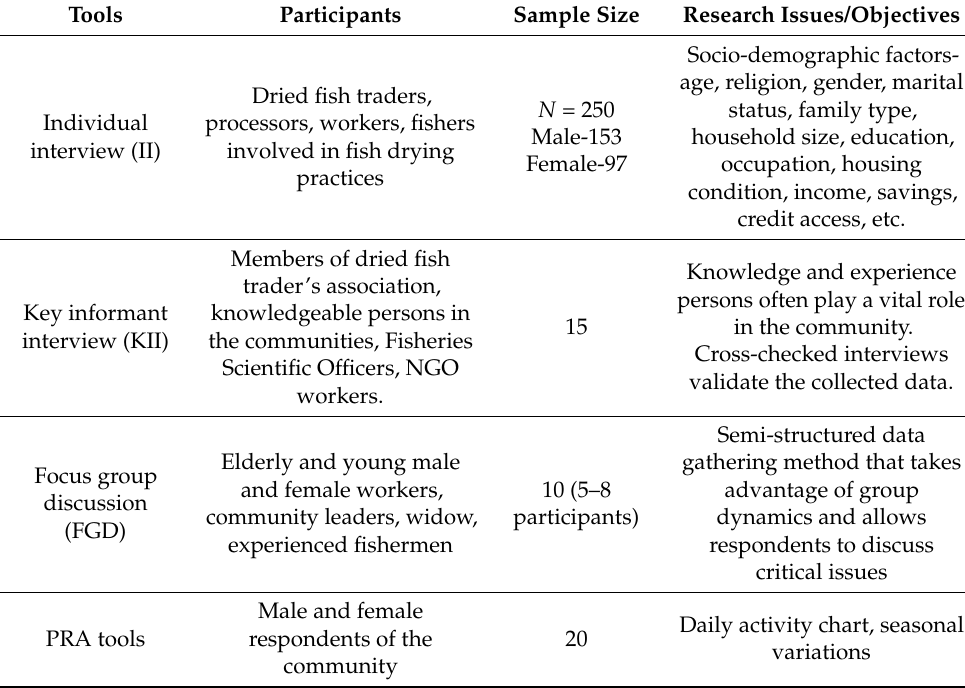
Table 1. An overview of empirical data collection